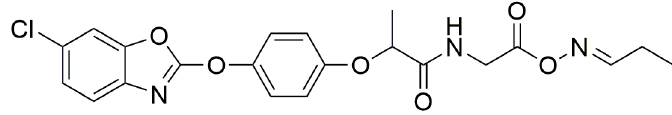
Figure 1. Glyamifop chemical structure and formula.